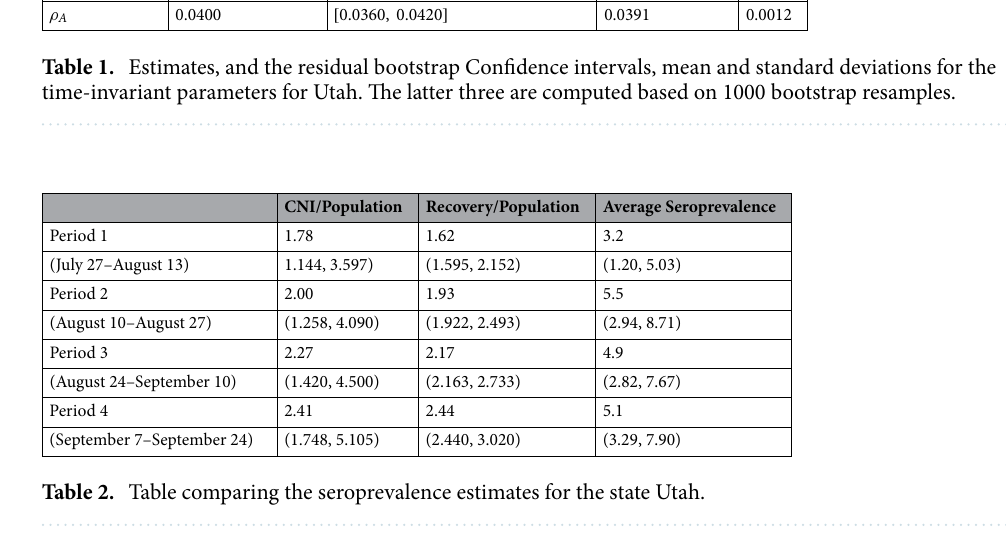
Table 3. The time-varying parameters, ( φ( t ) , ρ H ( t ) , δ( t ) ), are summarized by their means. The computed ˆ γ , that